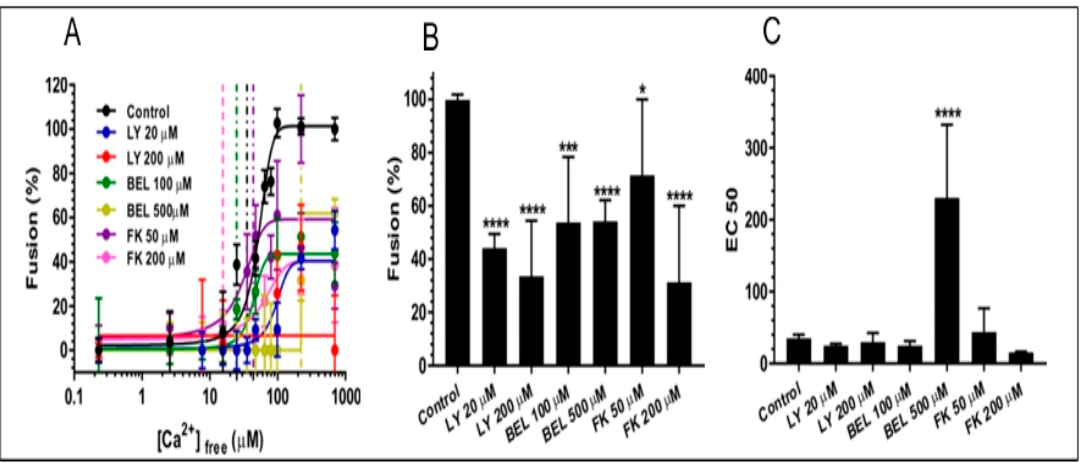
ff ects of LY311727 (selective for sPLA Figure 2. Effects of LY311727 (selective for sPLA 2 ) and BEL and FKGK-11 (both selective for iPLA 2 ) Figure 2. E